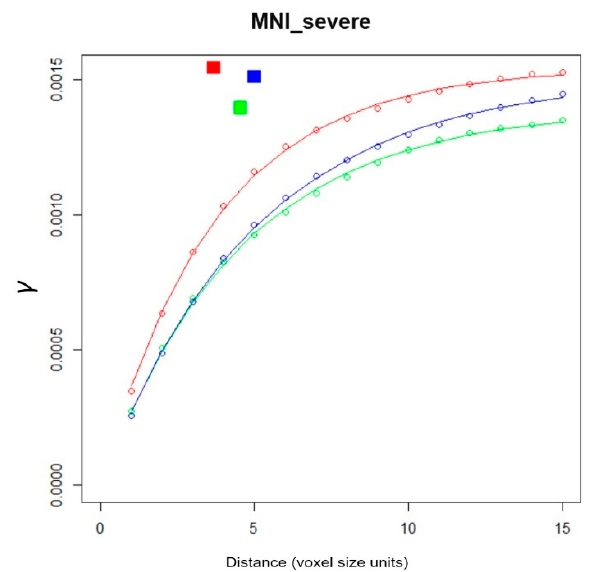
Figure 2. Variogram plot: Distance (abscissa) vs. γ (ordinate) with directional empirical variograms, separately fitted variogram models and associated model parameters a , c . Red, green, blue colors refer to variography x, y, z directions. Dots represent empirical directional variogram values, lines are fitted exponential variogram models, parameters a , c define coordinates of squares as derived from variogram modeling. Produced with LDPgenerator.r from binary MS-WML mask in Figure 1. See text for details.